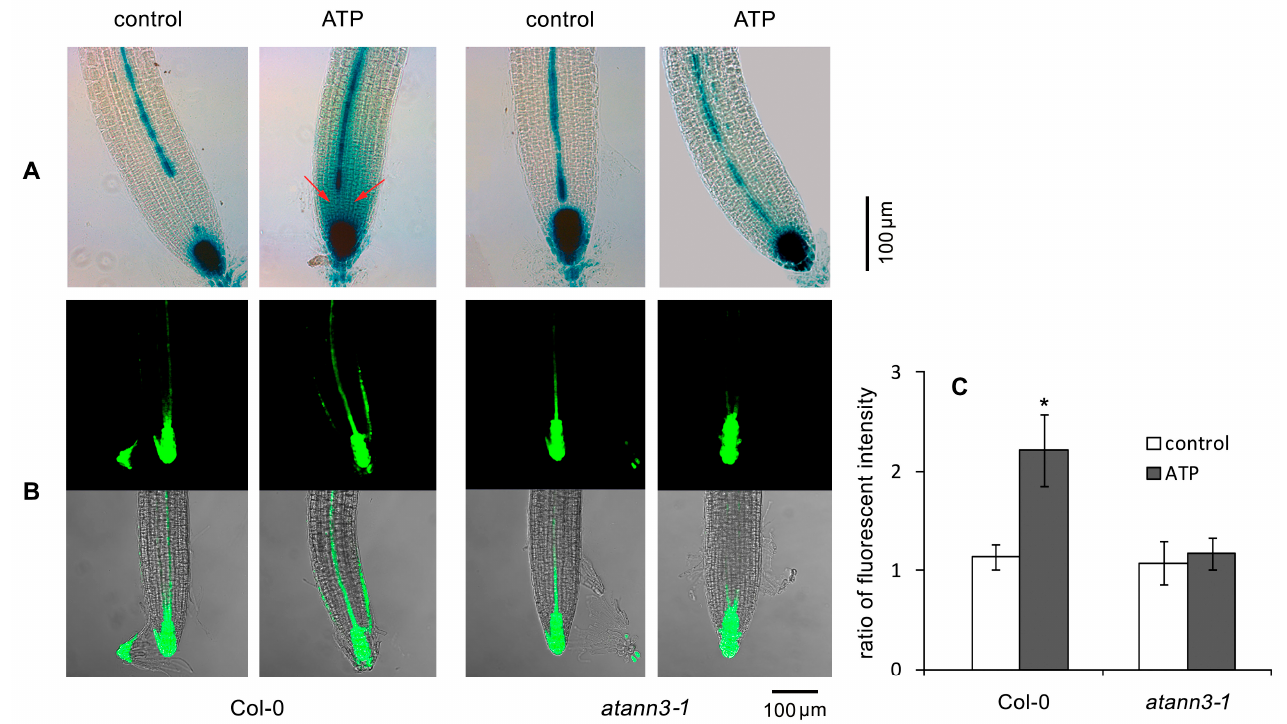
Figure 2. AtANN3 is involved in the eATP-induced distribution of DR5-GUS or DR5-GFP in root-tip cells. The 4-day-old seedlings of DR5-GUS or DR5-GFP transgenic lines were transplanted onto the medium containing 0.5 mM ATP and cultured for 2 more days. ( A ) The DR5-GUS expression in representative root-tip cells; red arrows indicate the area with the accumulation of DR5-GUS. ( B ) The DR5-GFP fluorescence in representative root-tip cells. The scale bar is shown in the lower-right corner of the figure. ( C ) The fluorescence intensity ratio (FIR) in the cells at the inner side/outer side of the root curve. In this experiment, at least 15 samples were measured, and data obtained from at least three replicates were combined to obtain mean ± SD based on Student’s t -test (* p < 0.05). 2.3. AtANN3 Is Involved in the eATP-Induced Auxin Transport and